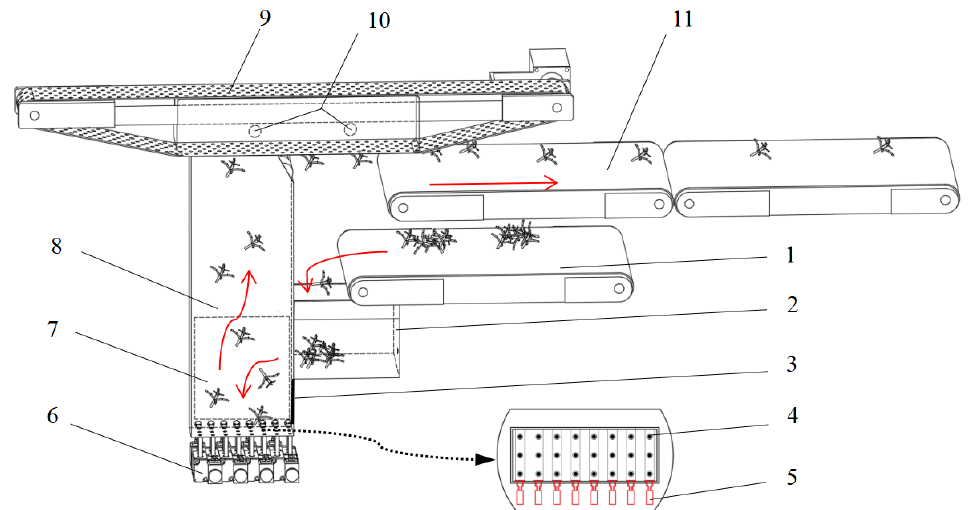
Figure 2. Separation system of collected seedlings: 1. seedling supply belt, 2. seedling box, 3. lifting gate, 4. jet group, 5. photosensitive sensor, 6. group of solenoid valves, 7. light source, 8. separation container, 9. picking belt, 10. vacuum slot, 11. delivery unit of individual separated seedlings.